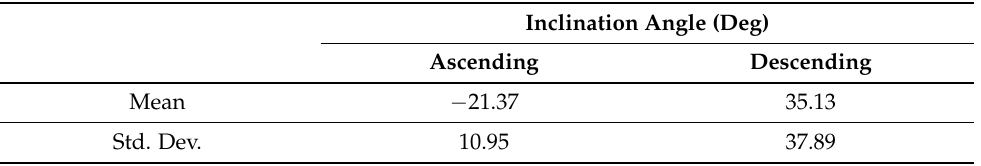
Table 9. Statistical analysis of variation in difference of inclination angle during ascending and descending experiments on the prototype with controlled and uncontrolled conditions.